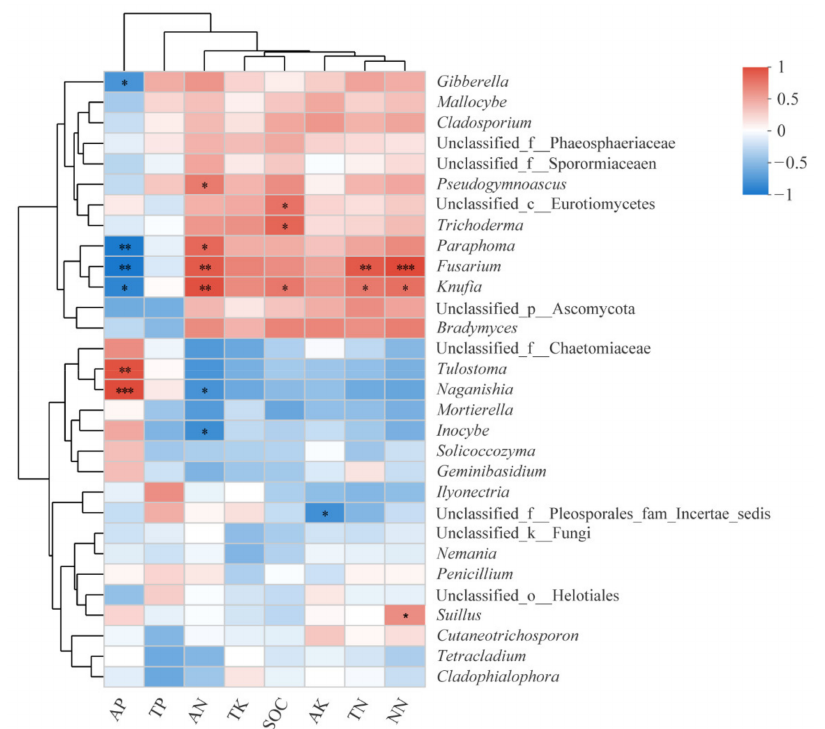
Figure 9. Correlation analysis between soil fungal community composition and soil properties in the rhizosphere of P. tabuliformis . AP: available phosphorus, TP: total phosphorus, AN: ammonium nitrogen, TK: total potassium, SOC: soil organic carbon, AK: available potassium, TN: total nitrogen, NN: nitrate nitrogen, *: significant at p < 0.05, **: significant at p < 0.01, and ***: significant at p <